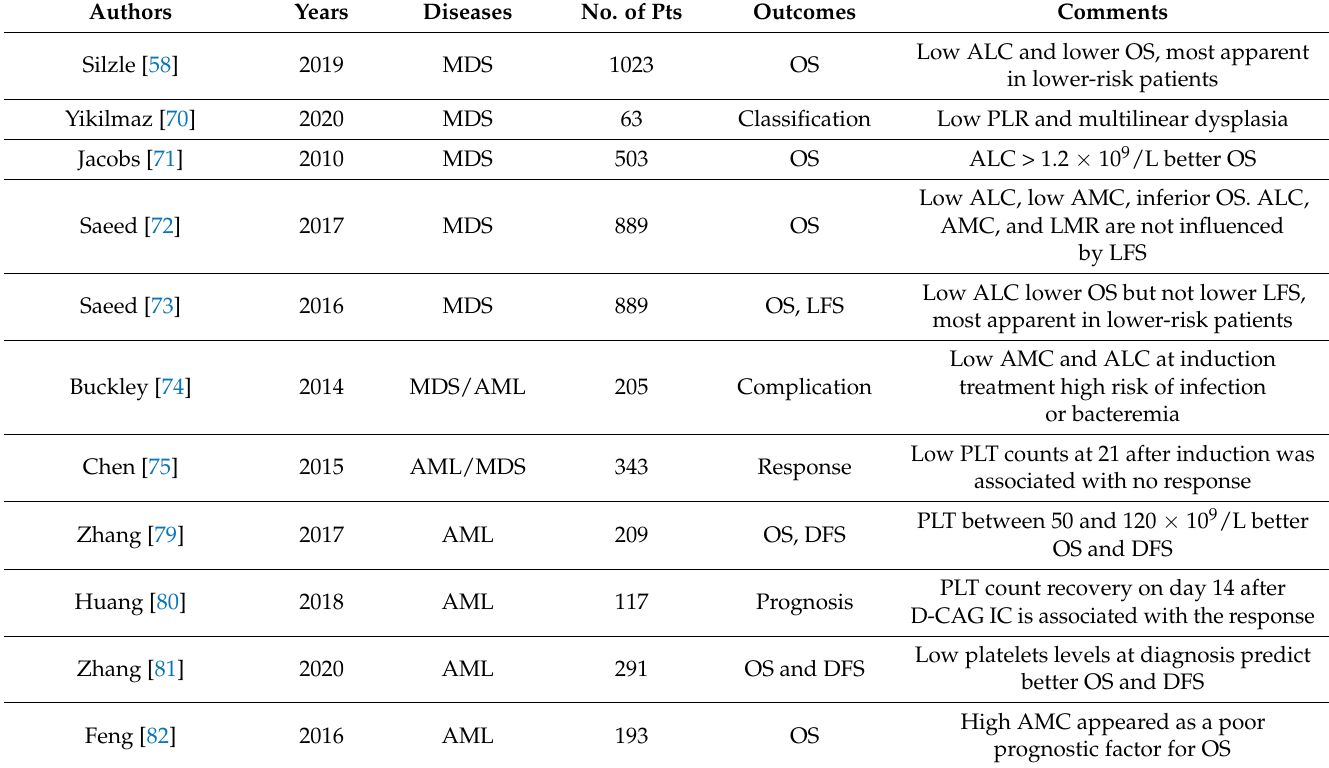
Table 2. Prognostic role of peripheral count blood cell parameters in acute myeloid leukemia and myelodysplastic